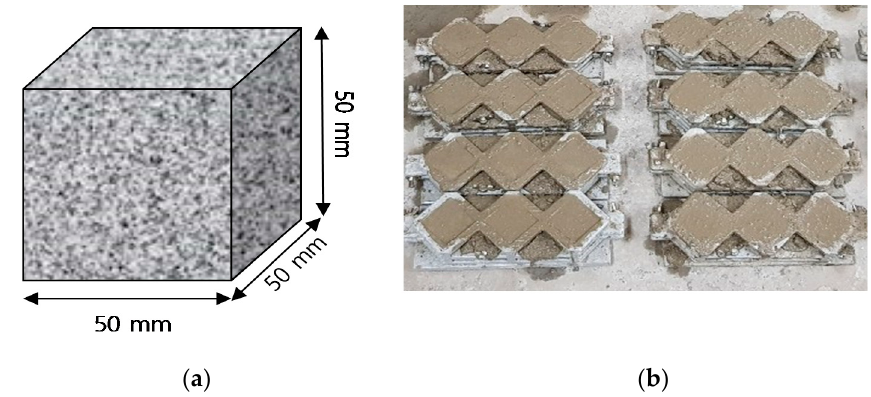
Figure 2. ( a ) Schematic diagram of Specimen; ( b ) 50 mm × 50 mm × 50 mm square cement mortar